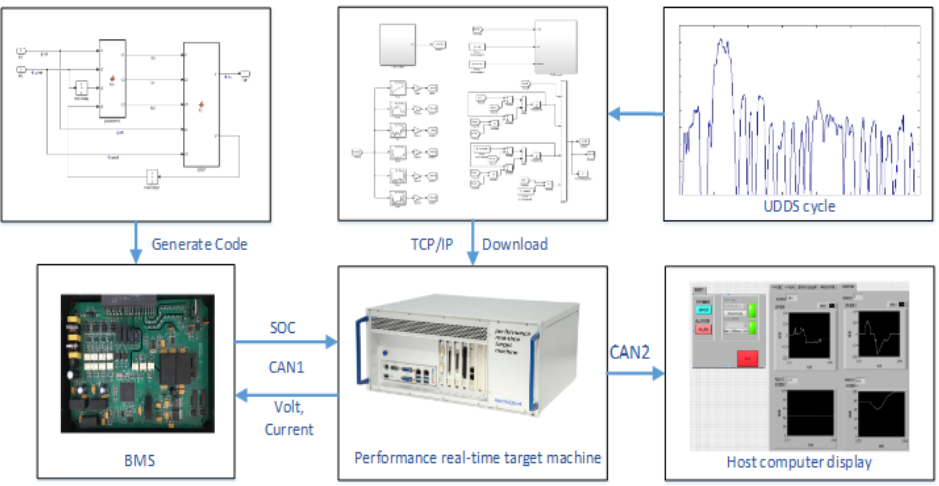
Figure 12. Hardware in the loop test scheme.